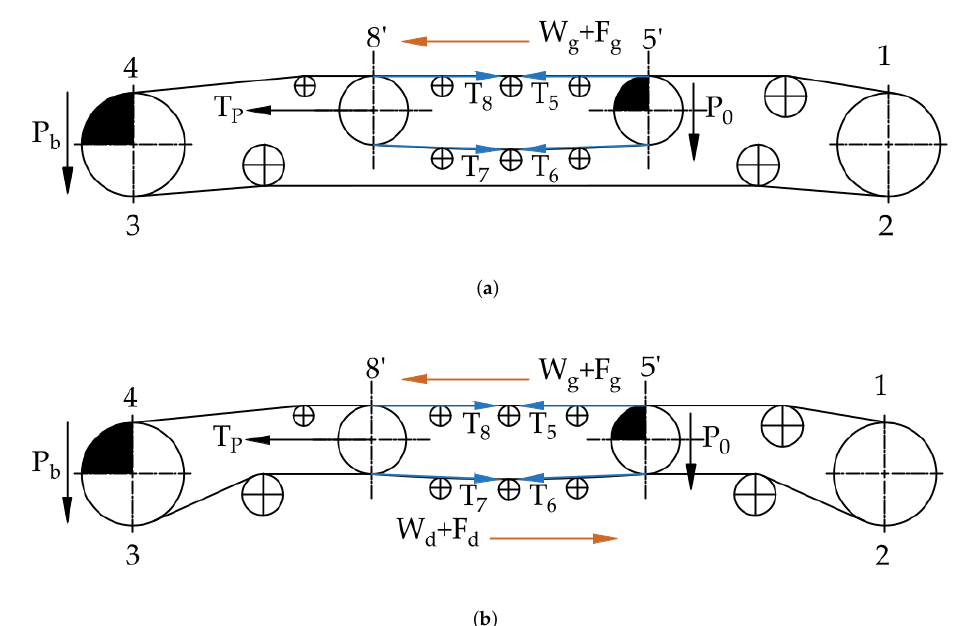
Figure 4. Tested variants of the intermediate drive operation: ( a ) friction coupling carry belt, ( b ) fric- tion coupling carry and return